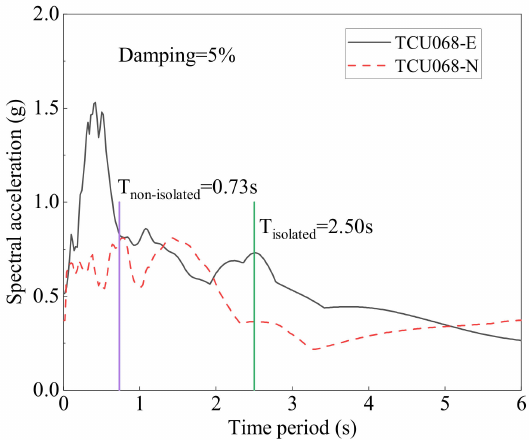
Figure 9. The acceleration spectra of the TCU068 ground motion.